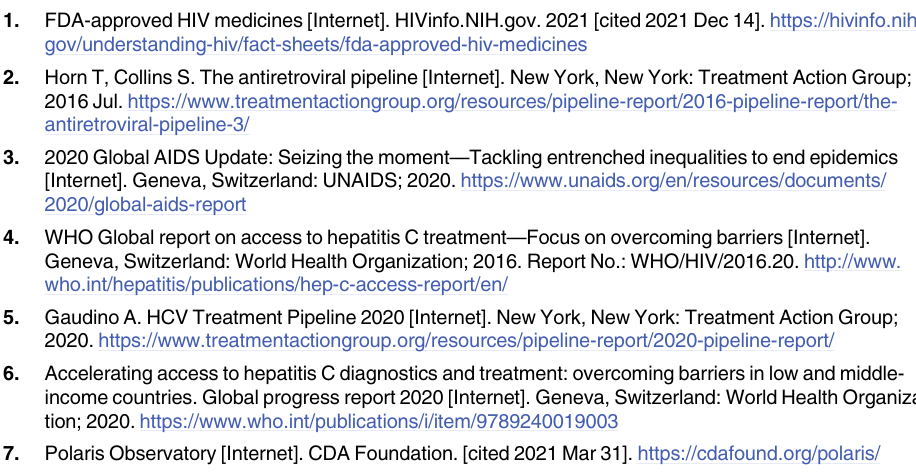
S1 Table. Number of participants, clinical trials and time to first regulatory approval for each drug. S2 Table. Phase 1 trials referenced in earliest approved FDA or EMA approval packages for each